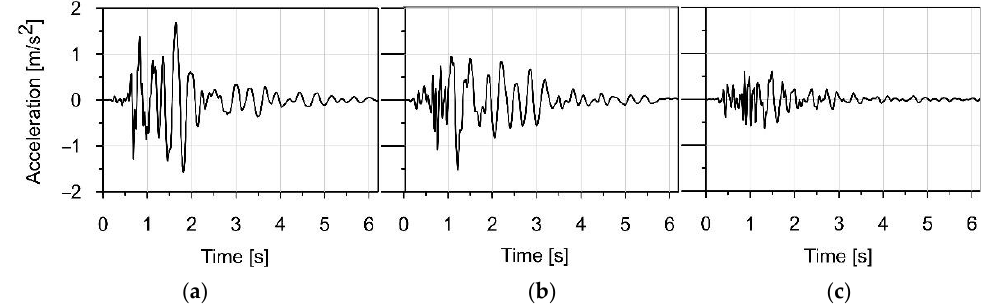
Figure 1. The time history of the ground acceleration registered in the USCB region: ( a ) horizontal direction WE; ( b ) horizontal direction NS; ( c ) vertical direction Z.